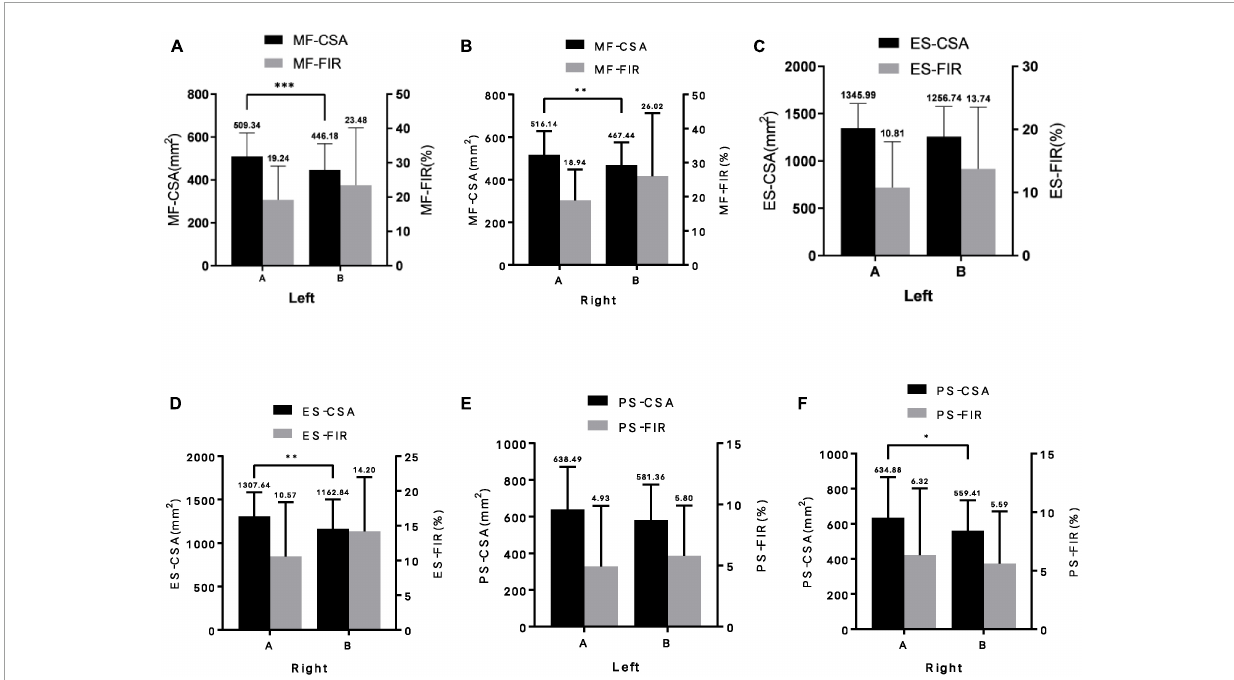
FIGURE2 Difference of paraspinal muscles parameters between the two groups (A, non-fracture group; B, fracture group). (A) left multifidus; (B) right multifidus; (C) left erector spinae; (D) right erector spinae; (E) left psoas major; and (F) right psoas major. MF-CSA, cross-sectional area of multifidus; MF-FIR, fat infiltration rate of multifidus; ES-CSA, cross-sectional area of erector spinae; ES-FIR, fat infiltration rate of erector spinae; PS-CSA, cross-sectional area of psoas major; PS-FIR, fat infilt ration rate of psoas major; Left, left paraspinal muscle; Right, right paraspinal muscle. Data are reported as mean ± standard deviation of mean. ∗ p < 0.05, ∗∗ p < 0.01, and ∗∗∗ p < 0.001.